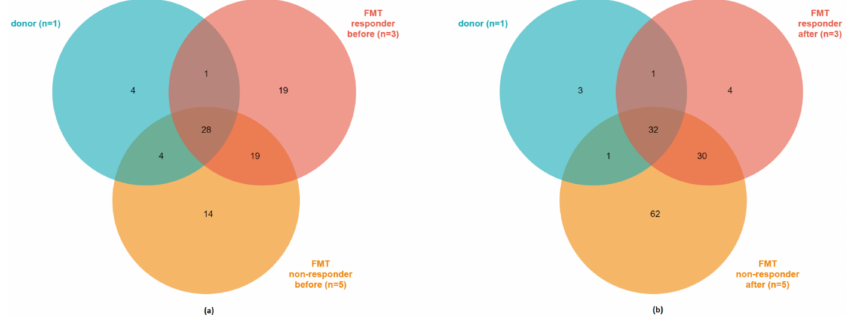
Figure 3. Venn diagram analysis of bacterial genera in healthy donor and patients with active left-sided UC treated with FMT ( a ) before the therapy (baseline) and ( b ) at all sampling points after the start of therapy. The number in each region represents genera shared between the sample groups (overlapping regions) or genera unique for the sample group. Number of subjects inside the group is indicated in